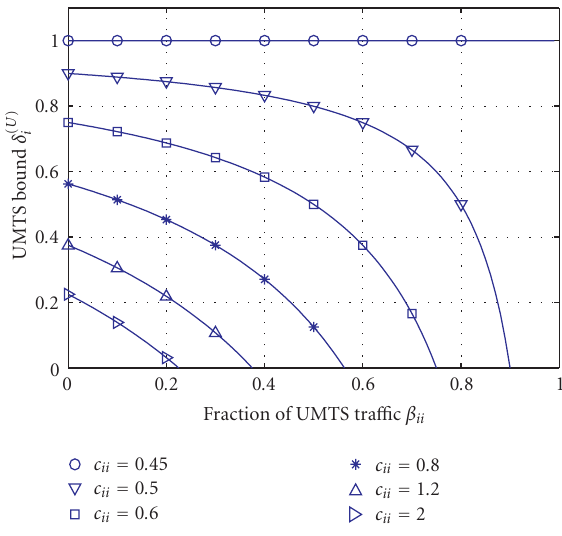
Figure 3: Broadcast bound δ ( B ) depending on the popularity shape κ and the total broadcast capacity.